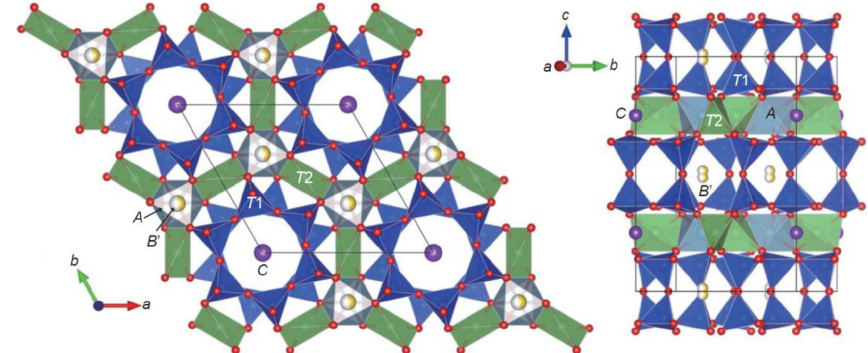
Figure 2. Crystal structure of aluminosugilite drawn with VESTA3 (Momma and Izumi, 2011). The A octahedra are occupied by octahedral trivalent cations, such as Al, Fe 3 + and Mn 3 + . The B (cid:48) and C sites are occupied by Na and K, respectively. The T 1 tetrahedra consist of double-ring units. The large T 2 tetrahedra centred by Li are strongly angularly distorted. The B (cid:48) site is located at 1 / 3, 2 / 3, z